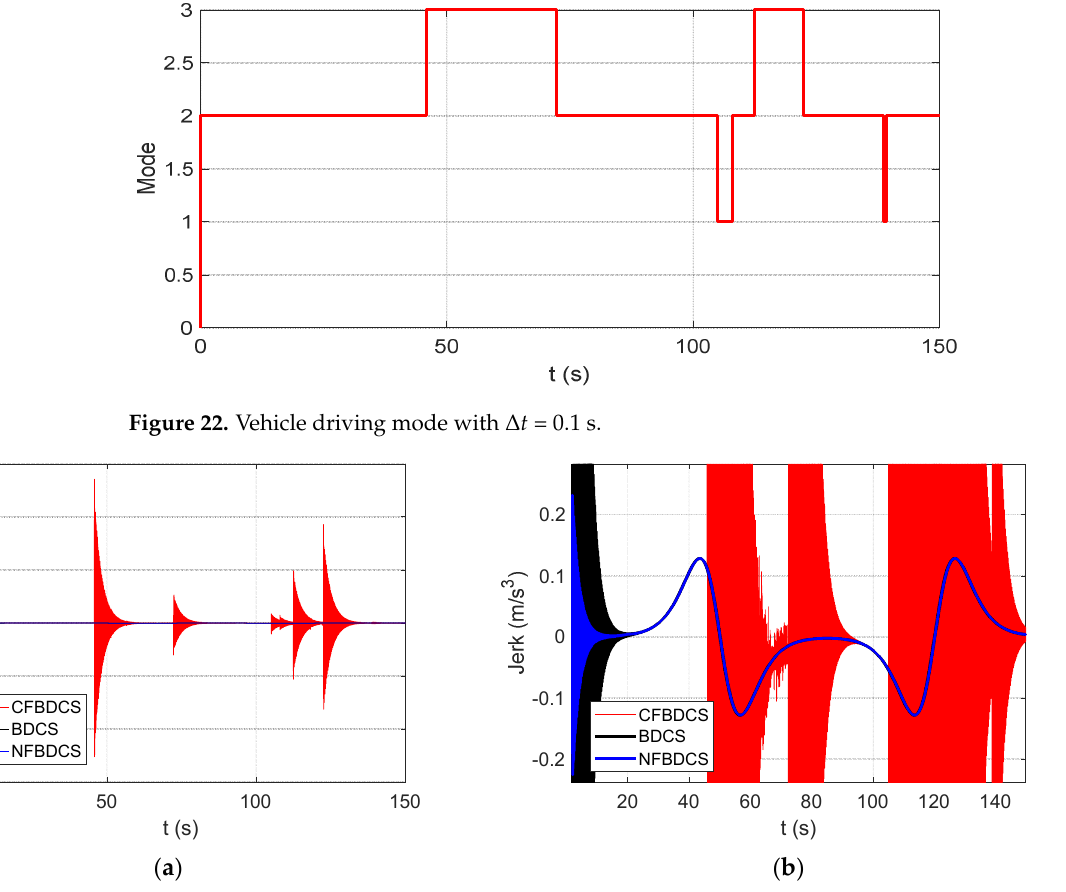
Figure 23. ( a ) Jerk of vehicle with Δ t = 0.1 s, ( b ) Jerk of vehicle with Δ t = 0.1 s (amplified).